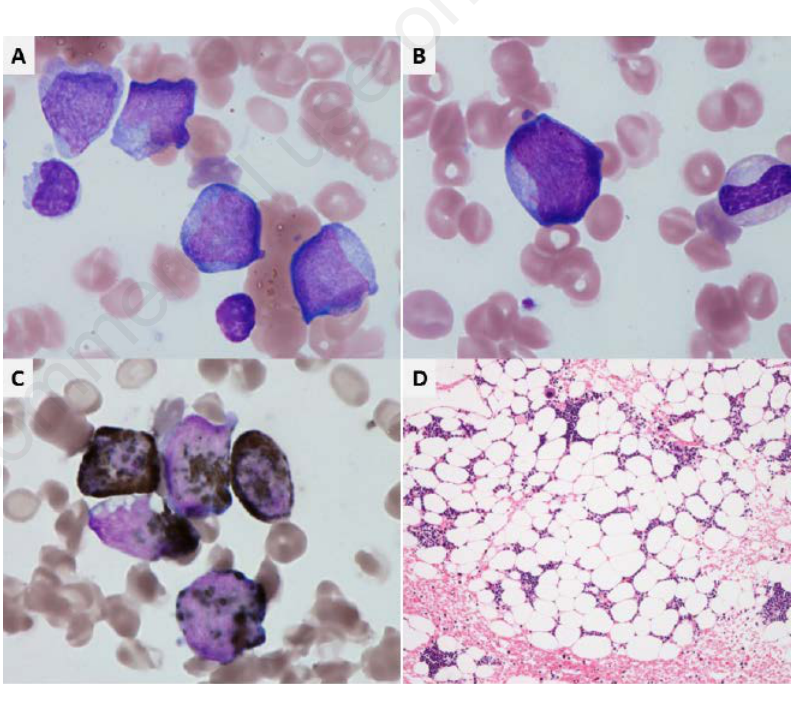
Figure 1. Morphology of bone marrow at the diagnosis as hypoplastic leukemia. A) and B) May-Giemsa stain. Blasts were slightly small, had Auer body and no dysplasia. C)